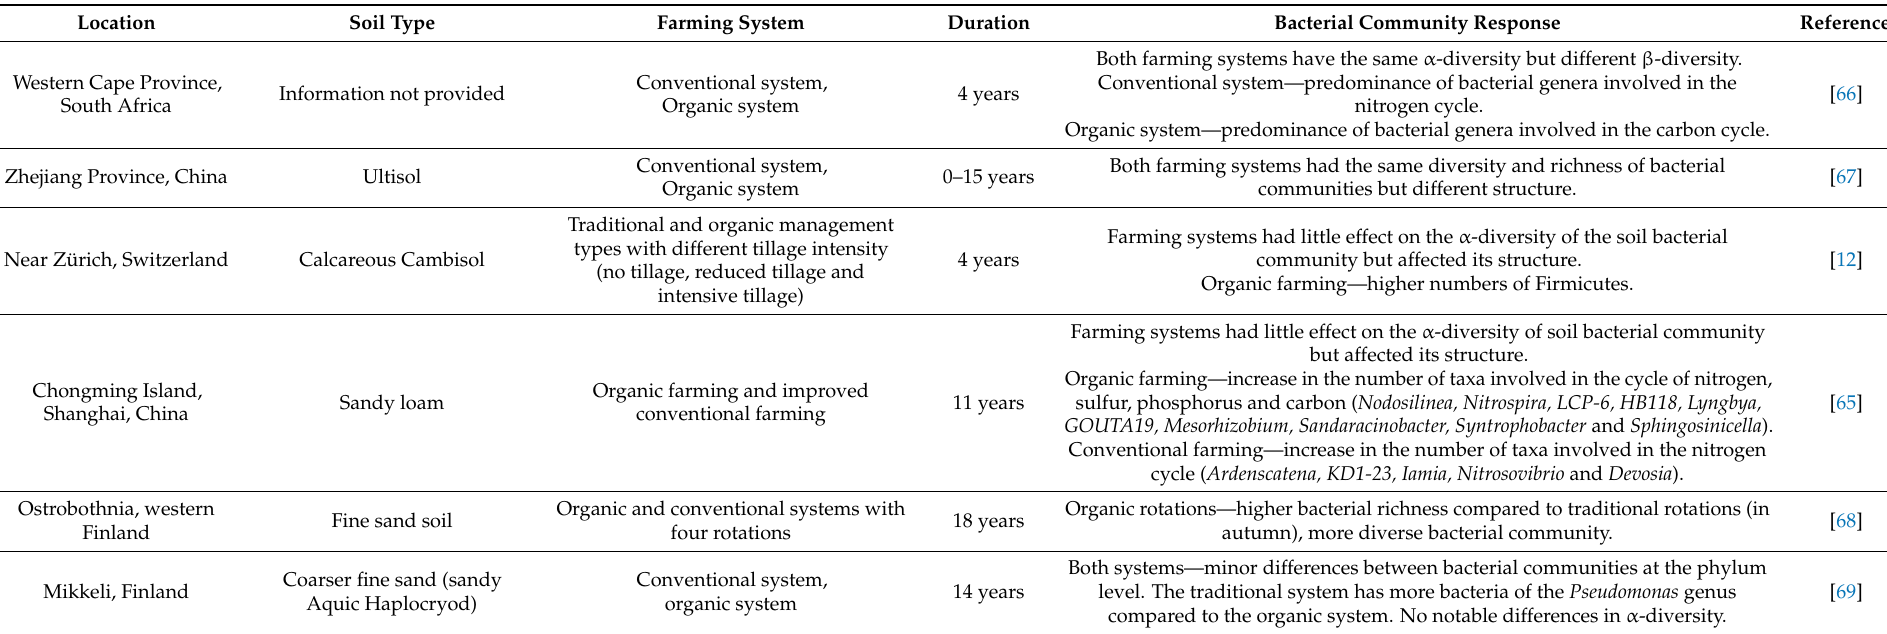
Table 3. Influence of the organic/conventional system on the bacterial community of agricultural